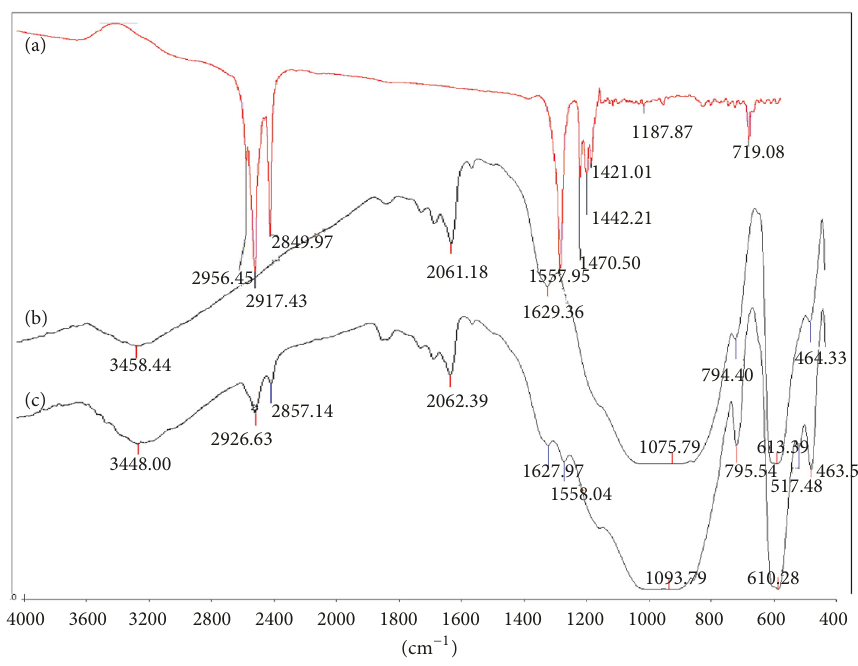
Figure 5: IR of TiO 2 modified by sodium stearate. (a) Sodium stearate; (b) TiO 2 ; (c) modified TiO 2 .